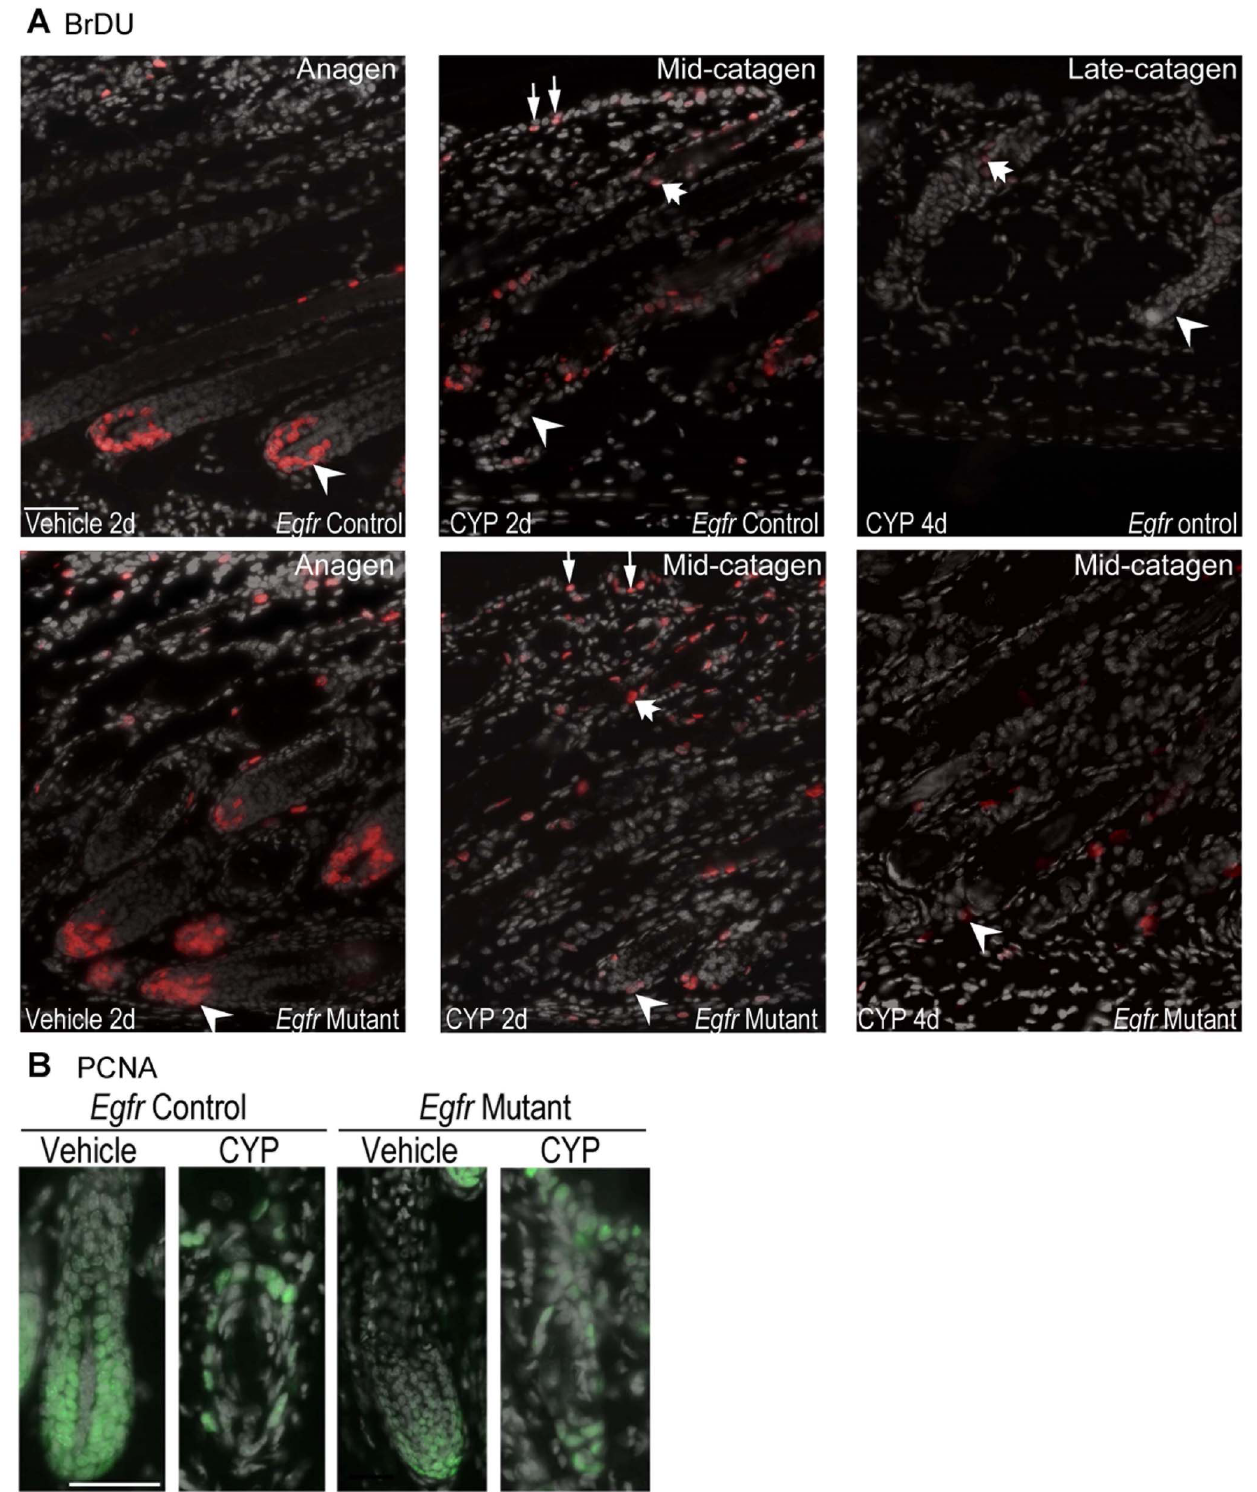
Figure 4. Proliferation in Egfr controls and mutants was decreased following cyclophosphamide. BrDU (A) and PCNA (B) immunofluorescence was performed in vehicle and cyclophosphamide treated control and mutant mice euthanized at 2 (A-B) or 4 d (A). A) Arrowheads indicate BrDU-labeled matrix keratinocytes, thin arrows BrDU positive epidermal keratinocytes and fat arrows BrDU positive keratinocytes in the distal follicle. BrDU positive cells are red with nuclear DAPI gray. B) PCNA labeled nuclei are green with nuclear DAPI in gray. CYP indicates cyclophosphamide. Scale bar indicates 50 m m.